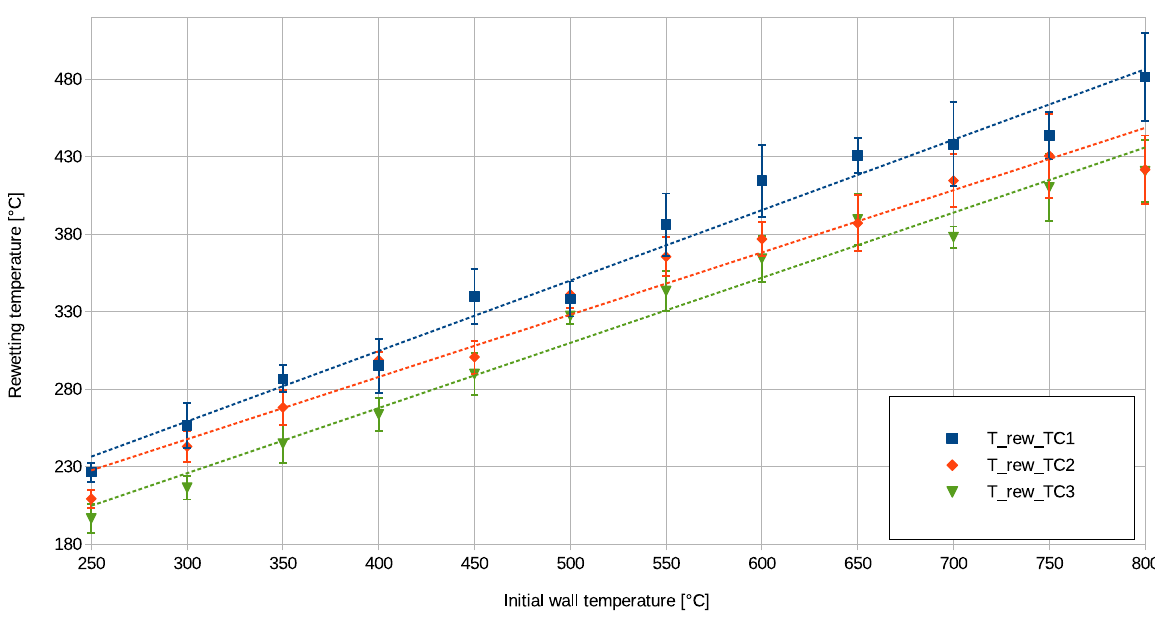
Figure 2. Rewetting temperature on initial wall temperature.